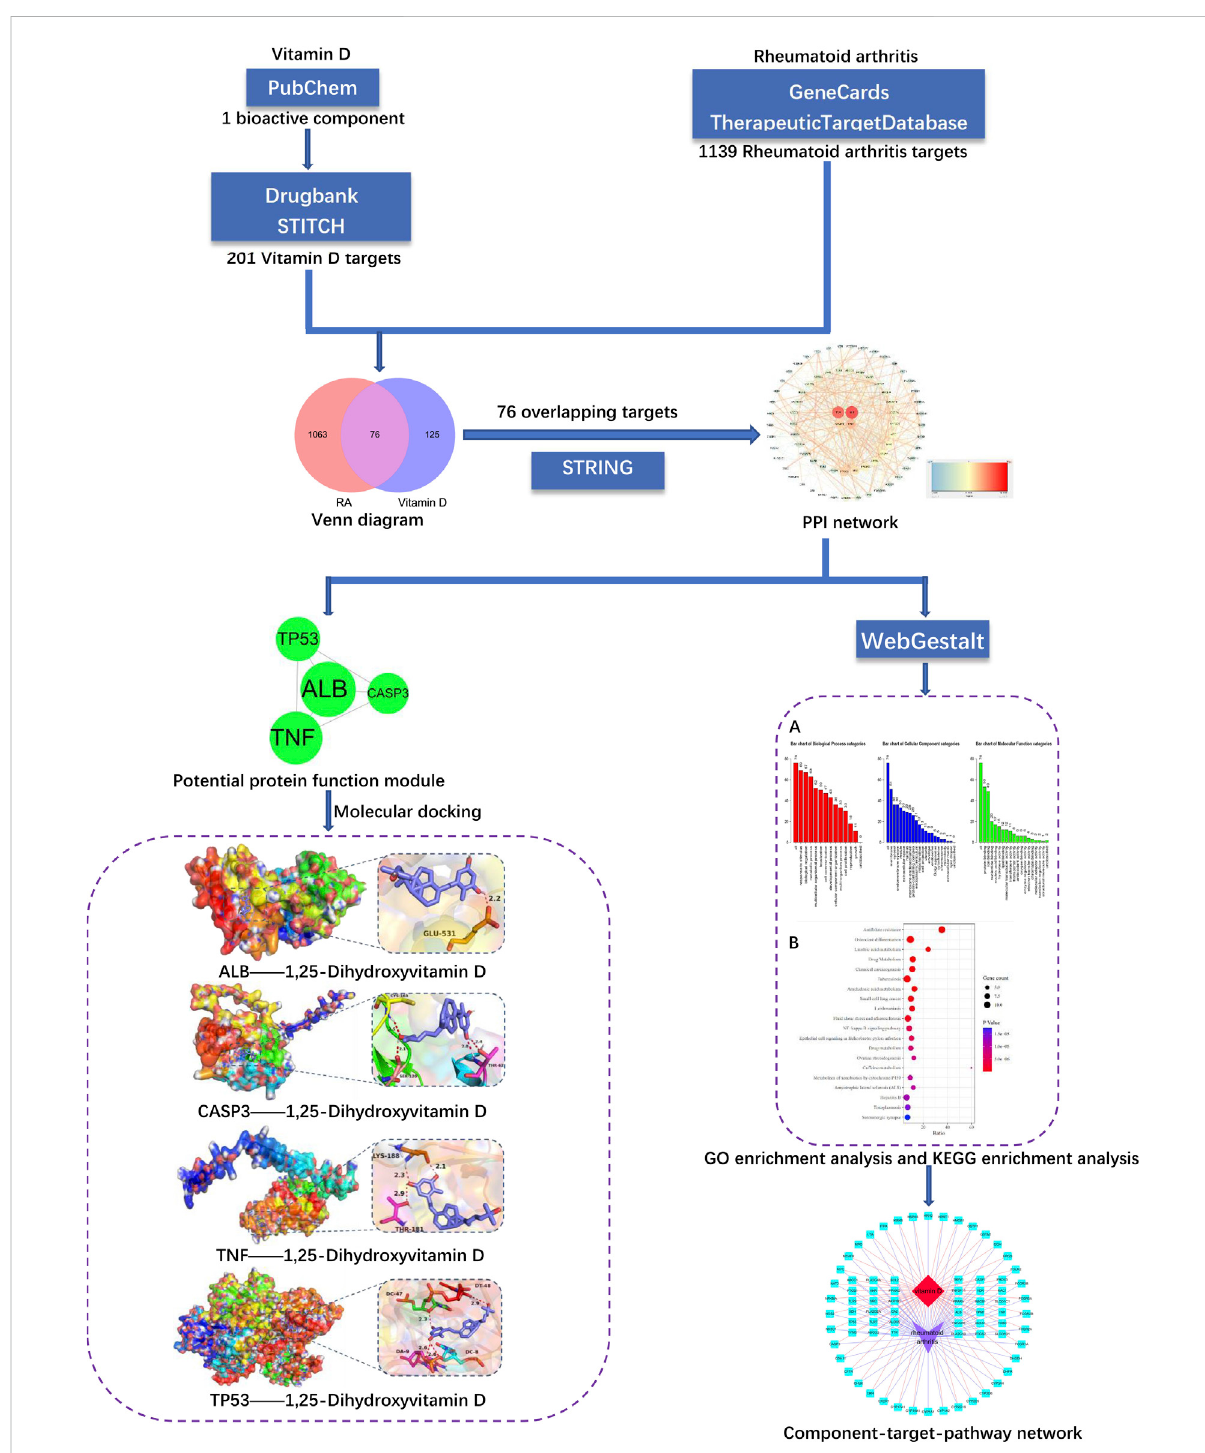
FIGURE 1 Schematic diagram of the